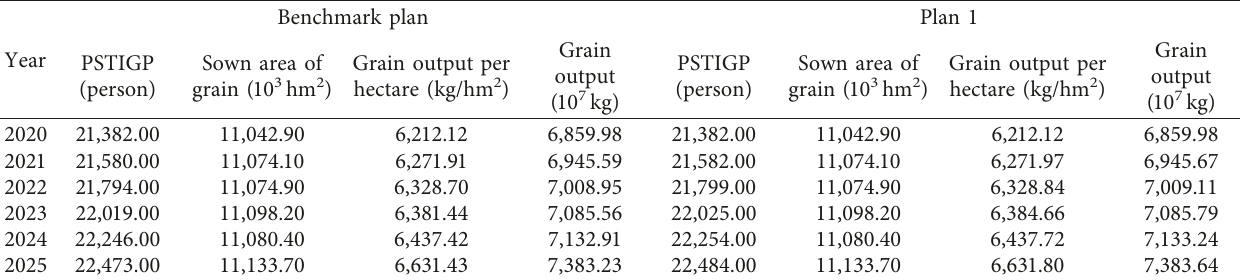
Table 6: Comparison of simulation results between Benchmark plan and Plan 1. Benchmark